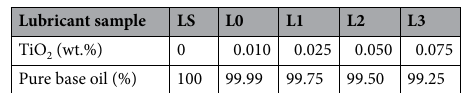
Table 2. Concentrations of the prepared nano